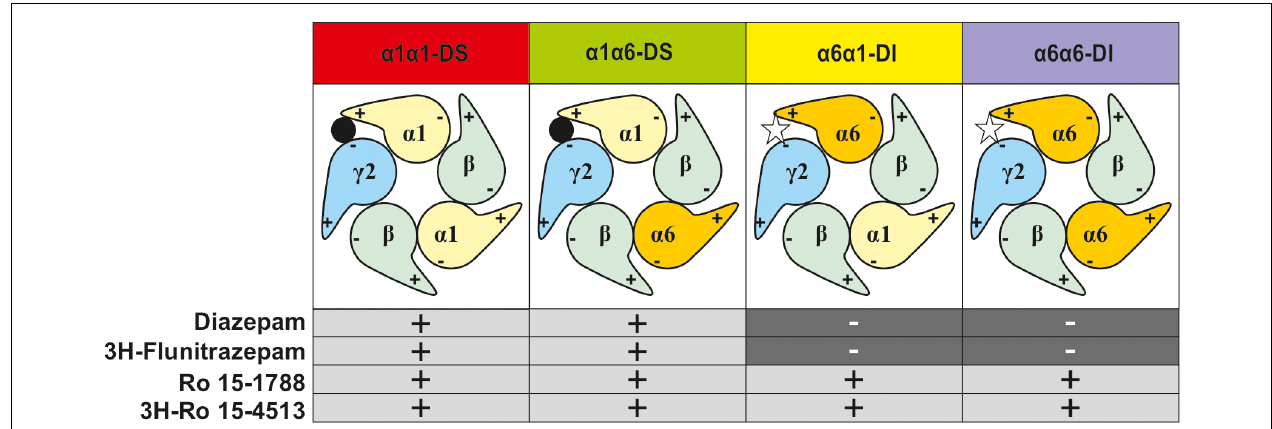
FIGURE 3 | Representation of the possible subtype combinations of γ 2-containing GABAA-receptors found in rat cerebellar granule cells and their pharmacological profile. The first named α -subunit is the γ 2-neighbor, and thus determines the drug sensitivity profile (diazepam-sensitive “DS” or diazepam-insensitive “DI”).